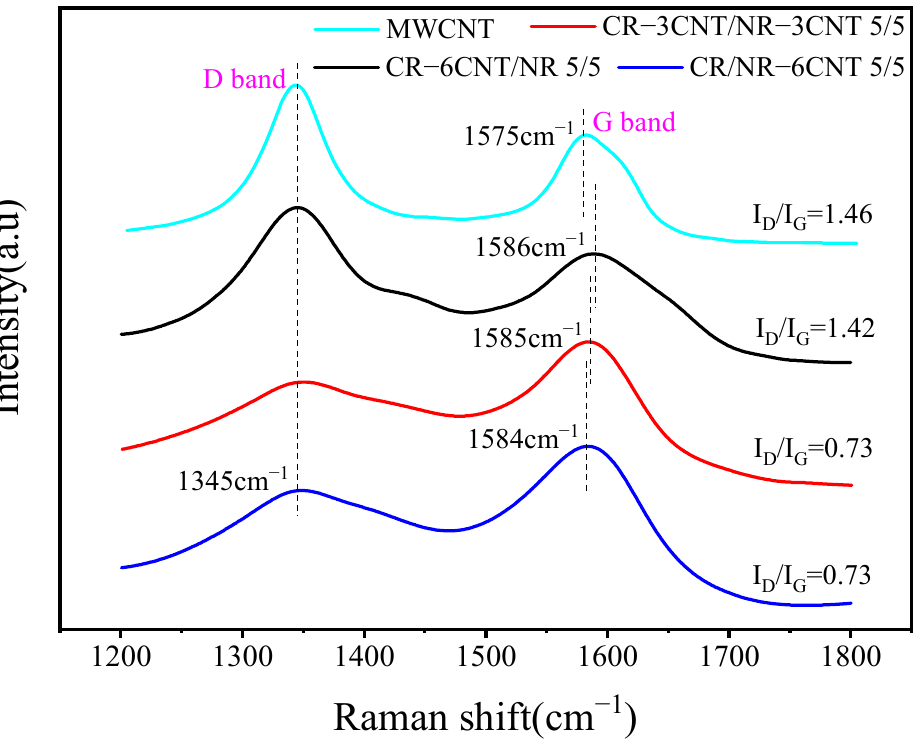
Figure 8. The Raman spectra of MWCNT/CR − NR composites under different blending processes.